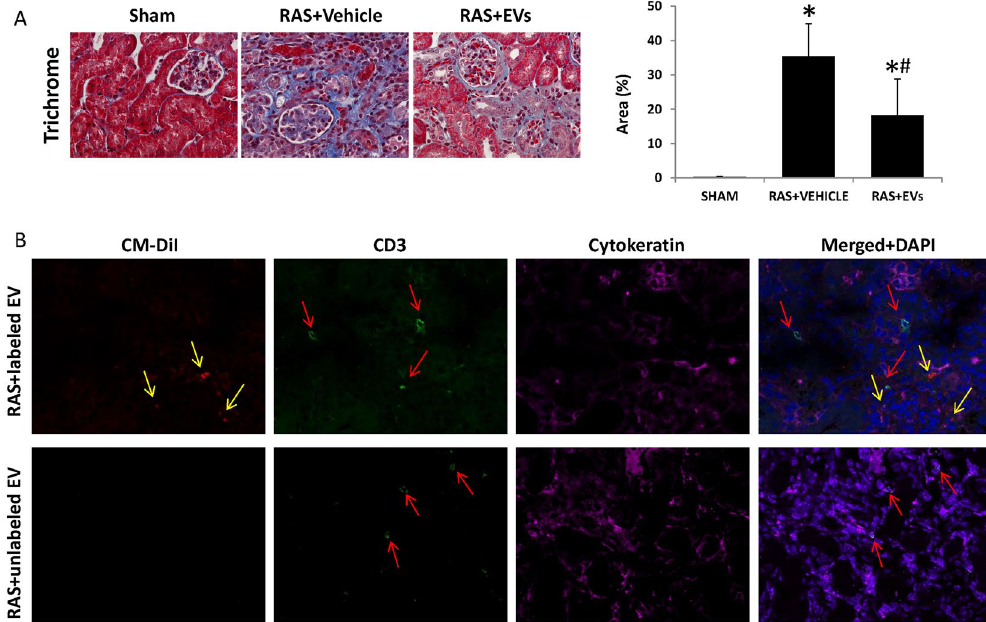
Figure 8. EV alleviated stenotic kidney fibrosis and improve its function. ( A ) Renal fibrosis increased significantly in RAS + Vehicle, whereas EV attenuated renal fibrosis. ( B ) Representative images of CM-Dil- labeled EV (red) and CD3-positive T cells (green) in the STK 2wks after delivery. Magenta shows tubular cell staining (cytokeratin). ( * P < 0.05 vs SHAM, # P < 0.05 vs RAS +